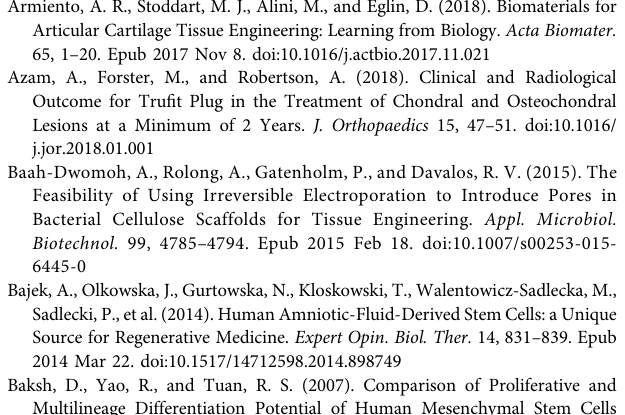
Figure S1 | The osteochondral (OC) tissue was observed with Safranin-O/Fast green staining in longitudinal (A) and cross (B) sections. And 3D-model of hyaline cartilage, calci fi ed cartilage zone and subchondral bone was reconstructed. The lower interface of tidemark (C), the upper interface of tidemark (D), the upper interface of cement line (E) and the lower interface of cement line (F) were shown respectively. Scale bar: 200 μ m. HC, hyaline cartilage; CCZ, calci fi ed cartilage zone; SB, subchondral bone; TM, tidemark; CL, cement line. Adapted with permission from ref (Wang F et al., 2009). Copyright 2009 by Elsevier